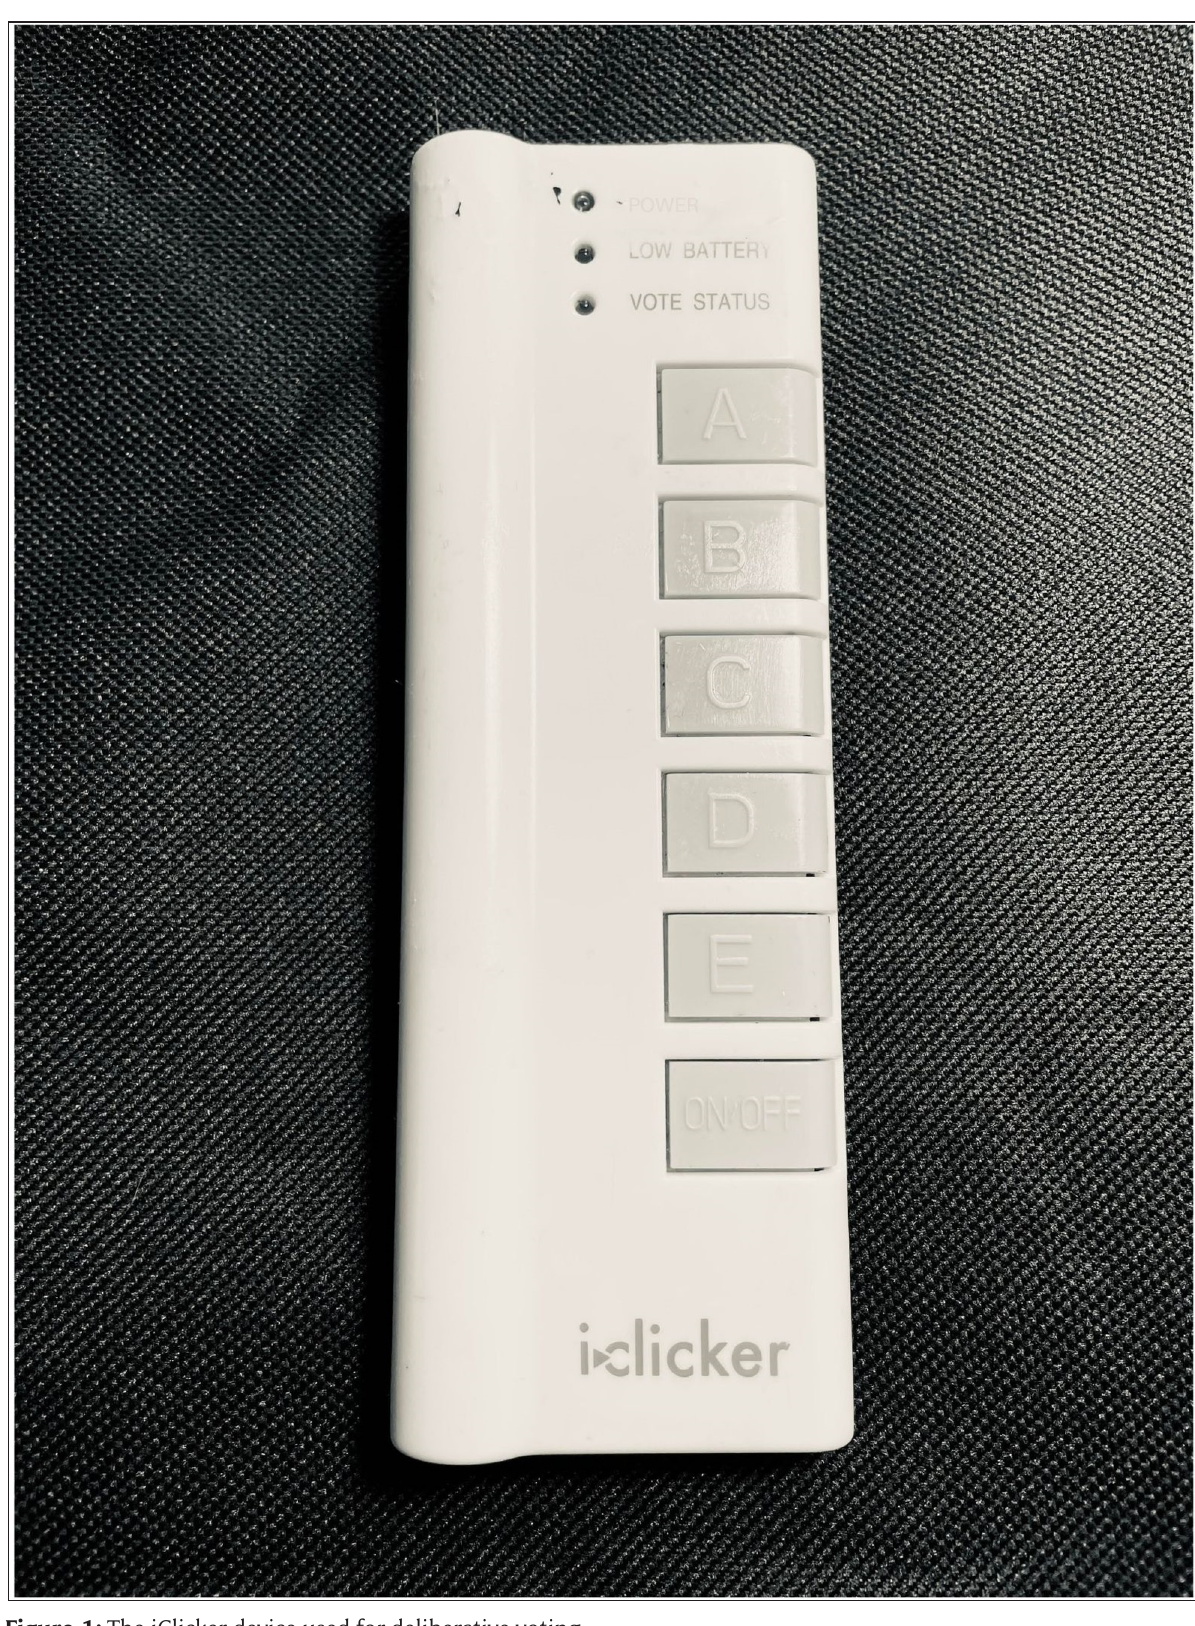
Figure 1: The iClicker device used for deliberative